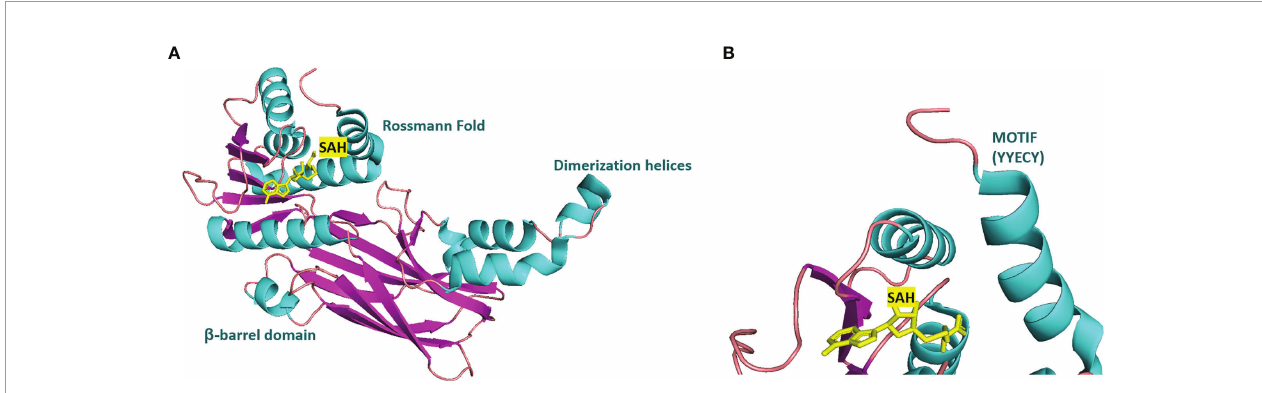
FIGURE 2 | Structural attributes of PRMT6. (A) Overall crystal structure of human PRMT6 (PDB: 6W6D, this work) in complex with SAH (marine yellow). (B) Structual superimposition of the conserved motif from PRMT6 (Motif: